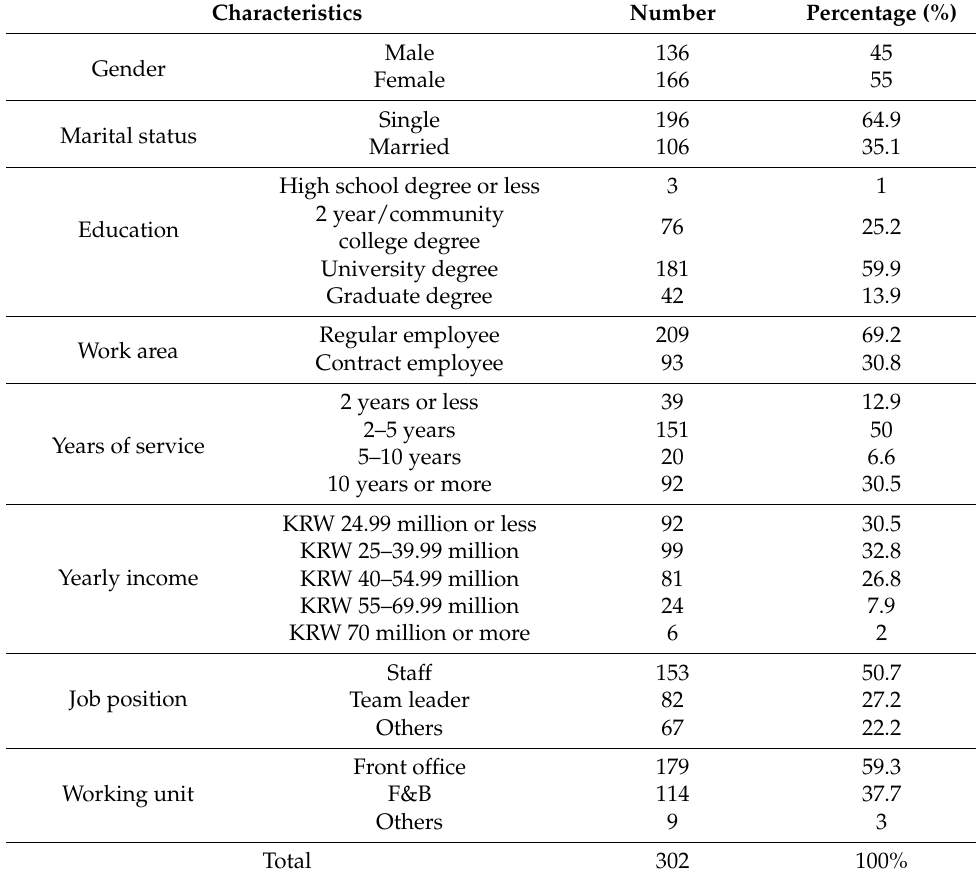
Table 1. Demographic